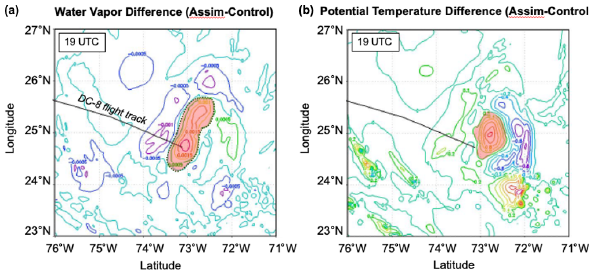
Figure 14. The 500m height wind field difference (assimilation minus control; ms − 1 ) that resulted after the first data assimila- tion period centered at 19:00UTC. (a) Zonal ( u ) wind compo- nent difference (ms − 1 ). (b) Meridional ( v ) wind component differ- ence (ms − 1 ). The red curves in each panel shows the approximate boundary between negative and positive contours in the vicinity of where the precipitation eventually developed. The DC-8 flight seg- ment during this time is shown.